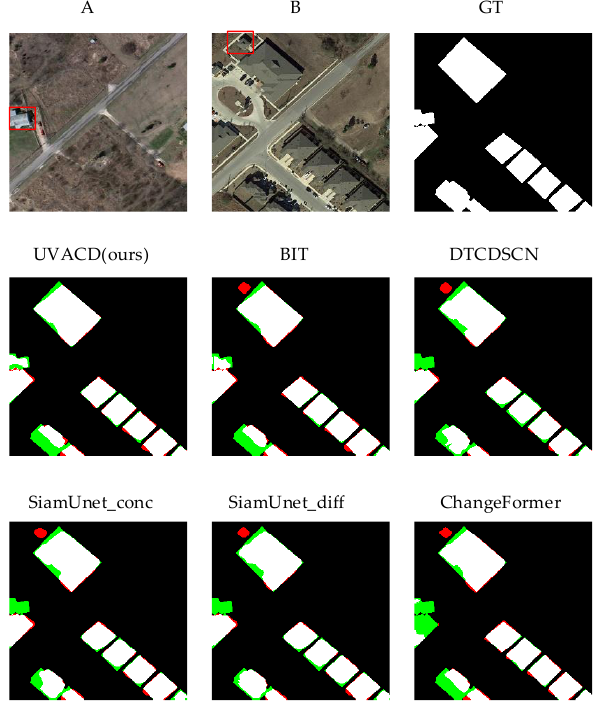
Figure 9. Qualitative results obtained by different methods on the LEVIR-CD dataset.